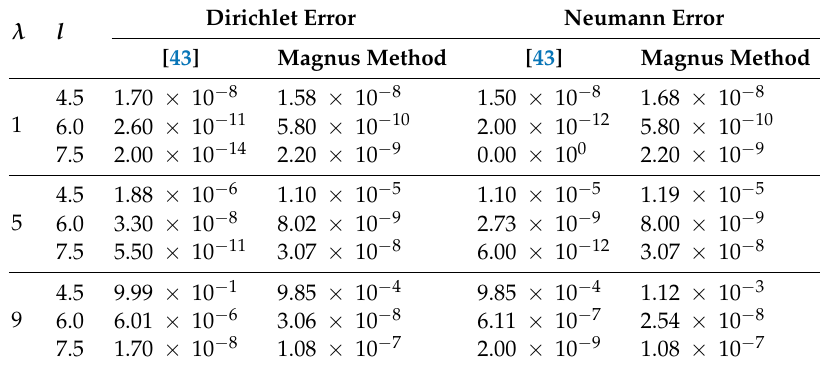
Table 1. Absolute errors for the first three eigenvalues of Equation (27) from Table 1 of Ta¸seli [43] and using Magnus method.